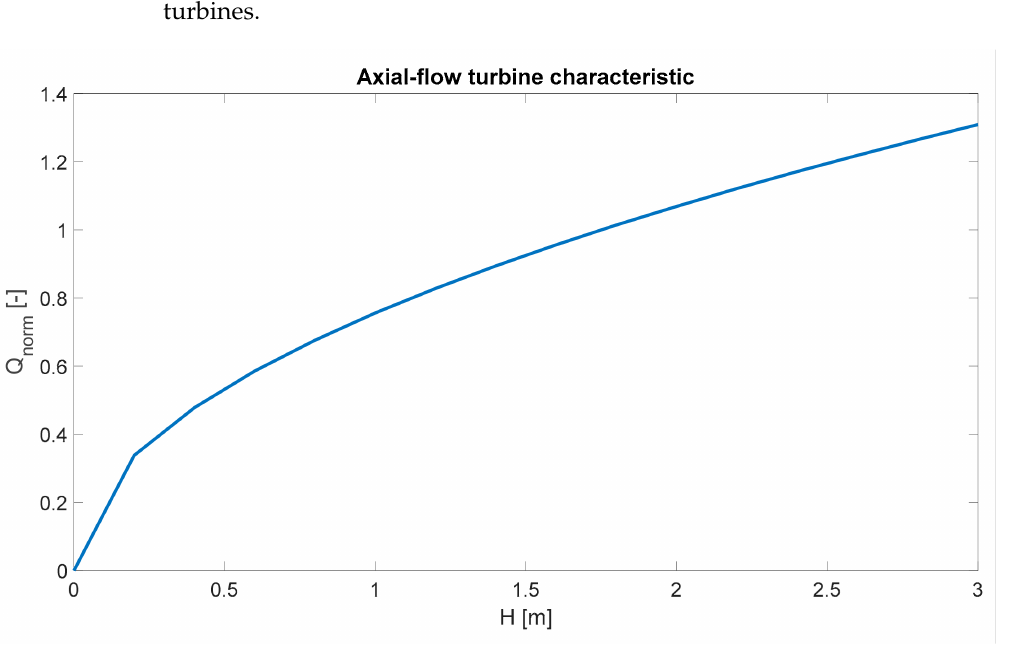
Figure 5. Normalized flow rate characteristic as function of the